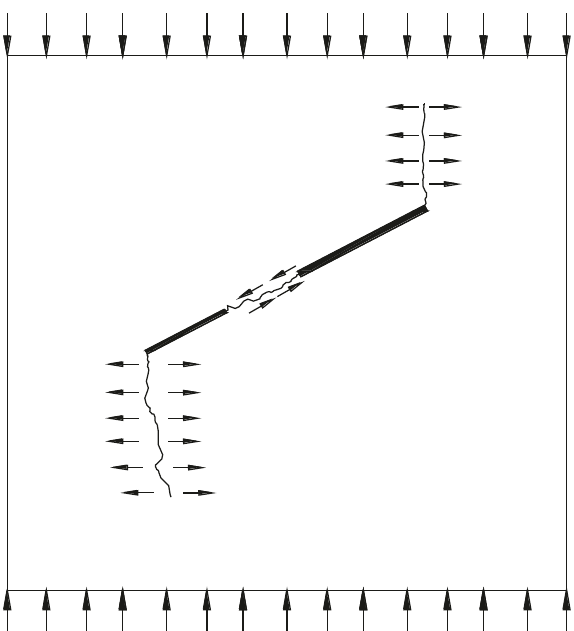
Figure 11: Schematic of tensile crack and shear crack under